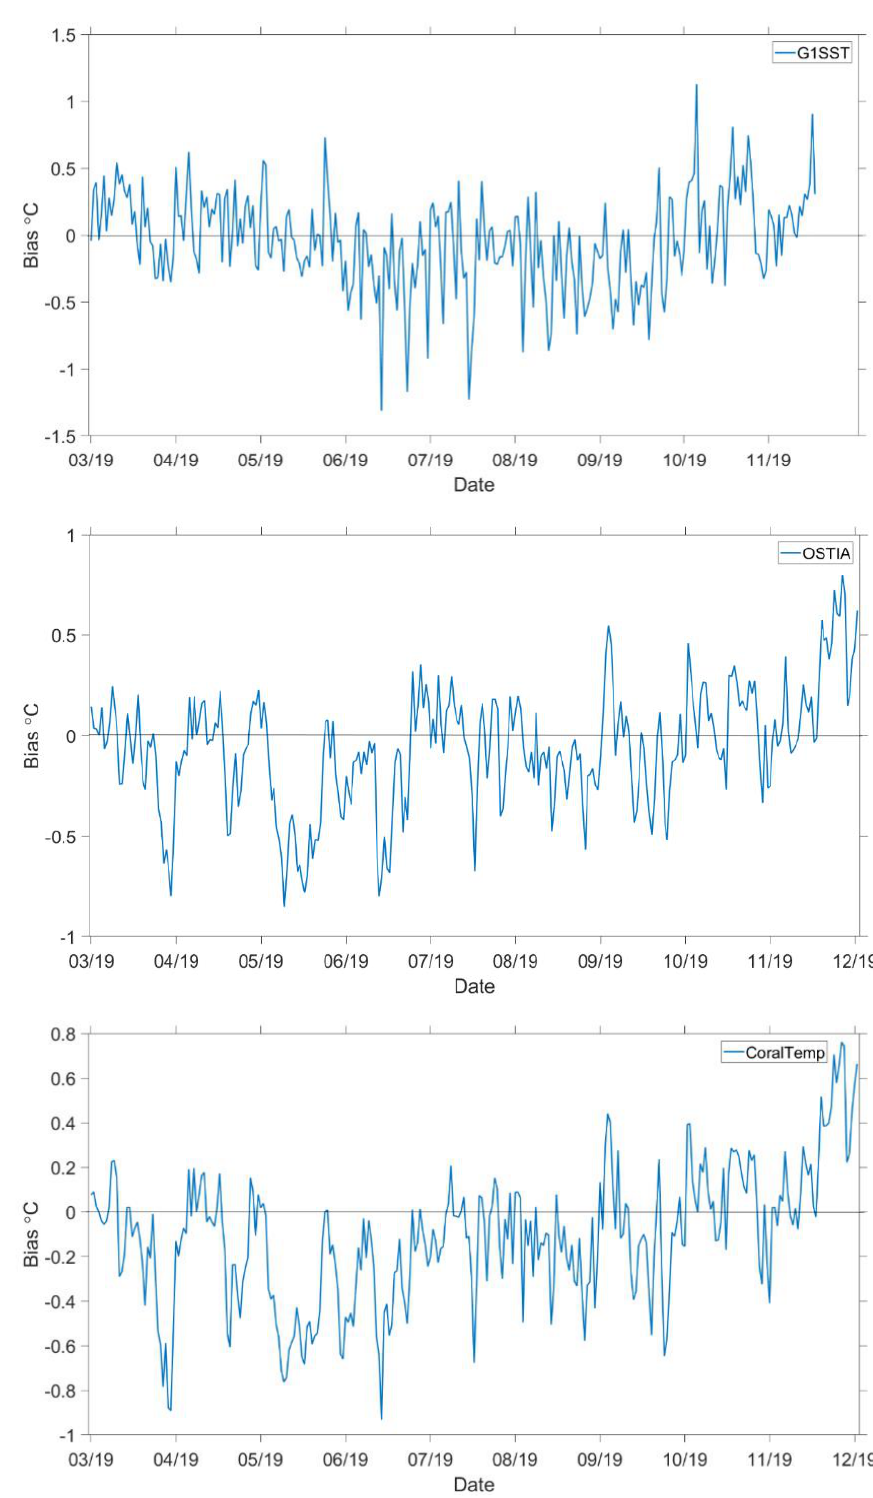
Figure 7. Time series of the bias (satellite—in situ) temperatures from 1 March 2019–24 December 2019 for CoralTemp and OSTIA, and from 1 March 2019–8 December 2019 for G1SST for Margarita Reef. The scatter plots indicated a strong linear relationship between all remote sensing SST